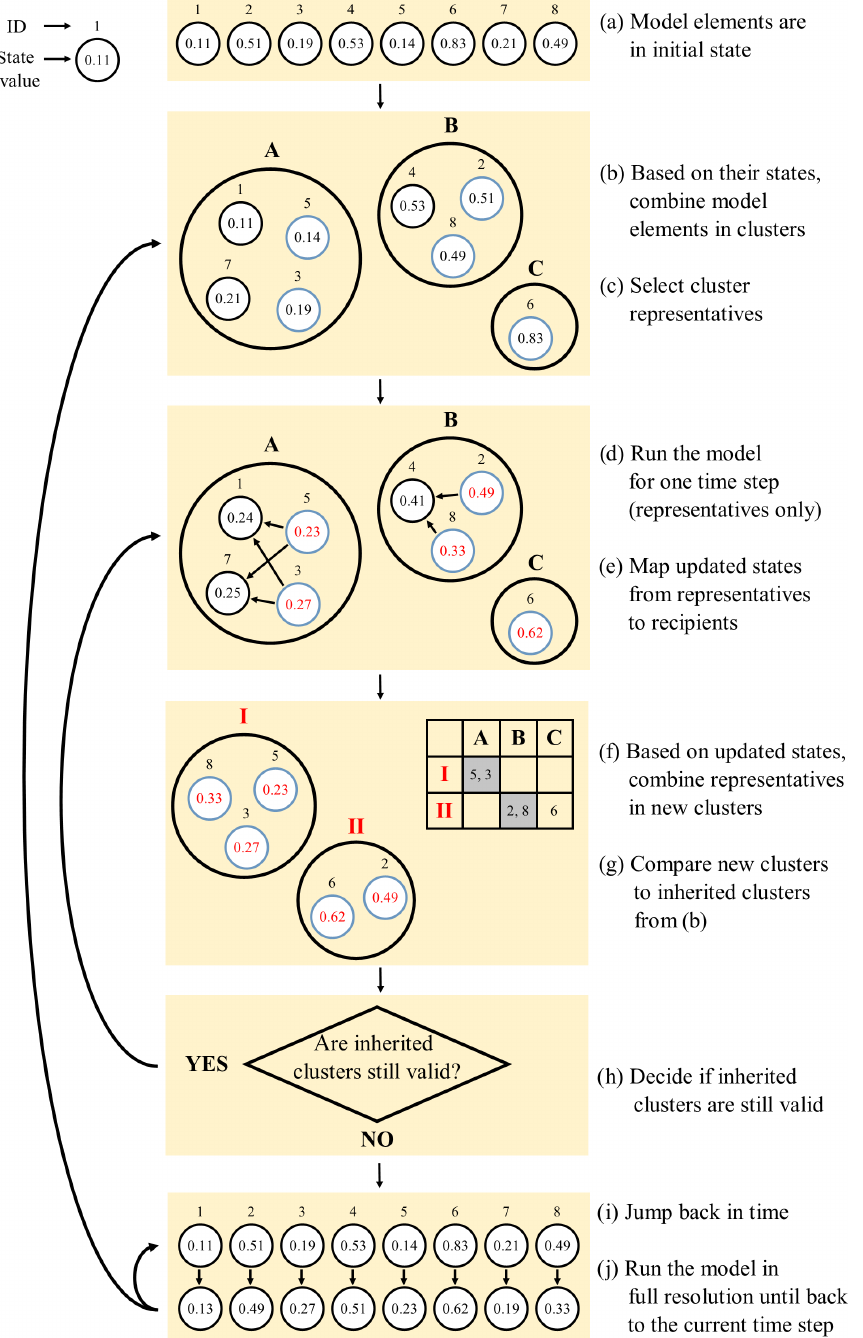
Figure 1. Main steps of adaptive clustering. A detailed explanation is given in the text.